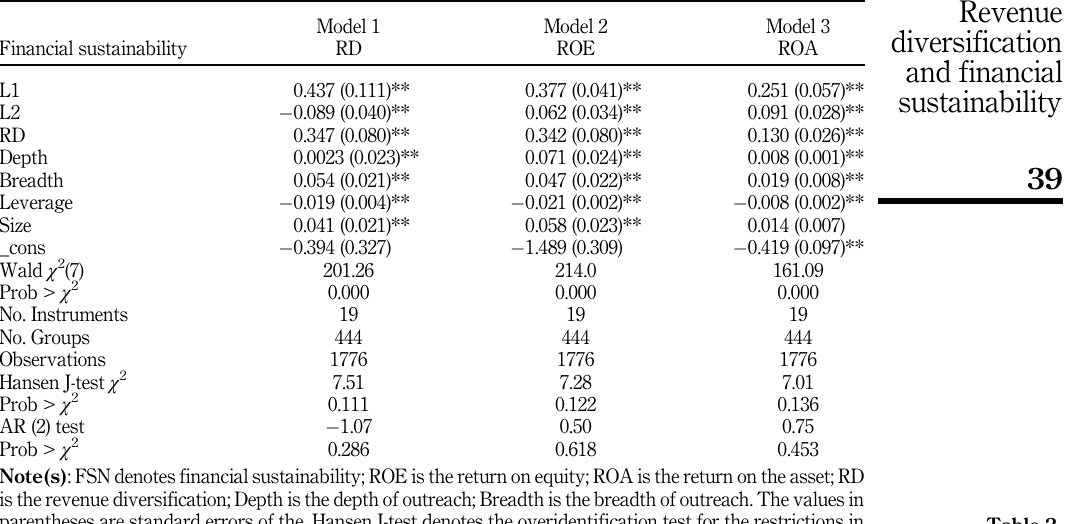
Table 2. Dynamic